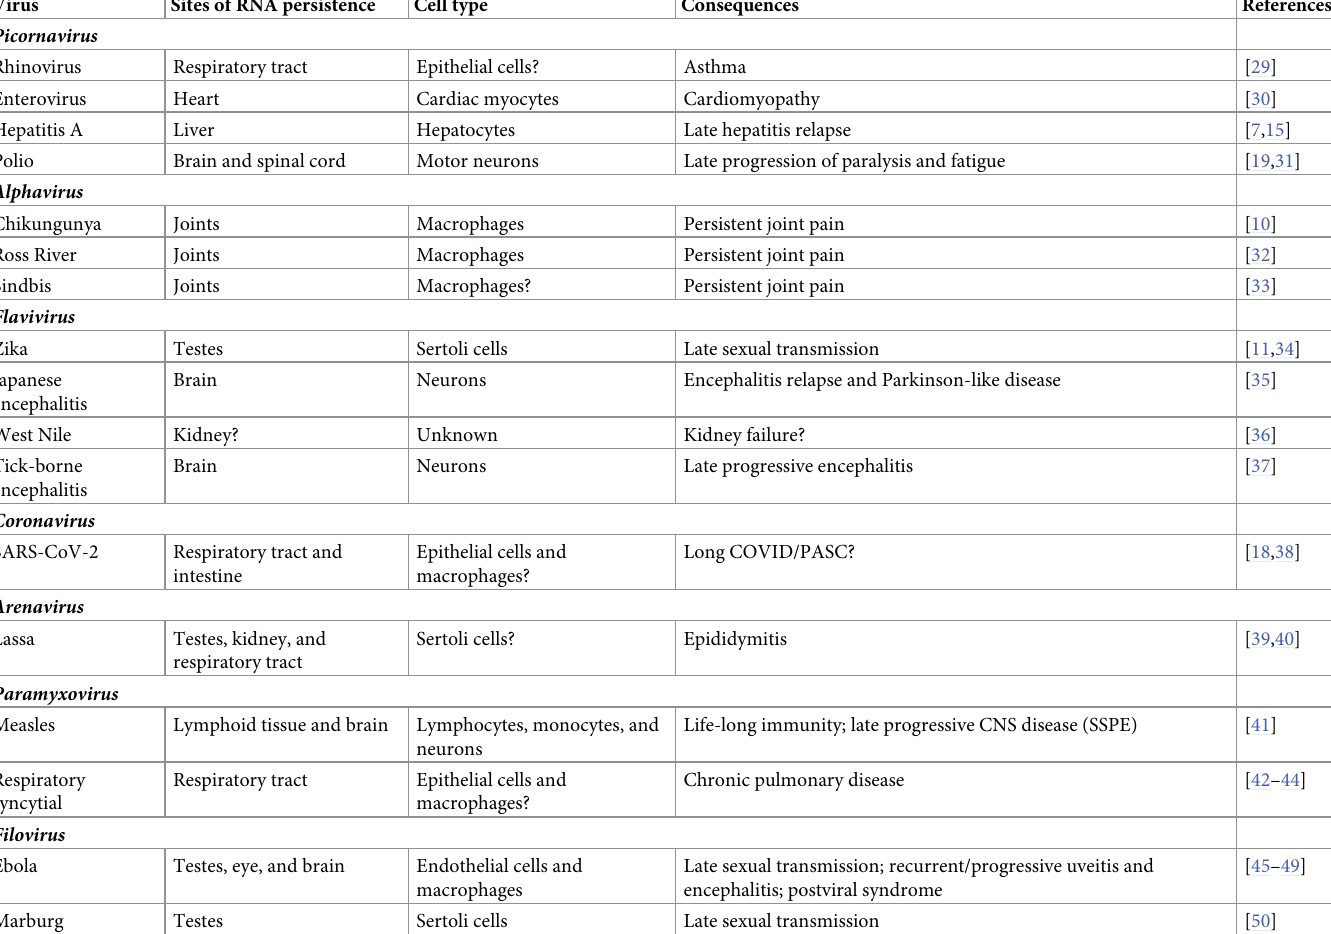
Table 1. AU : PleasecheckifTable 1 ispresentedcorrectly : Potential sites and consequences of RNA persistence after human infection with acute nonretroviral RNA viruses.